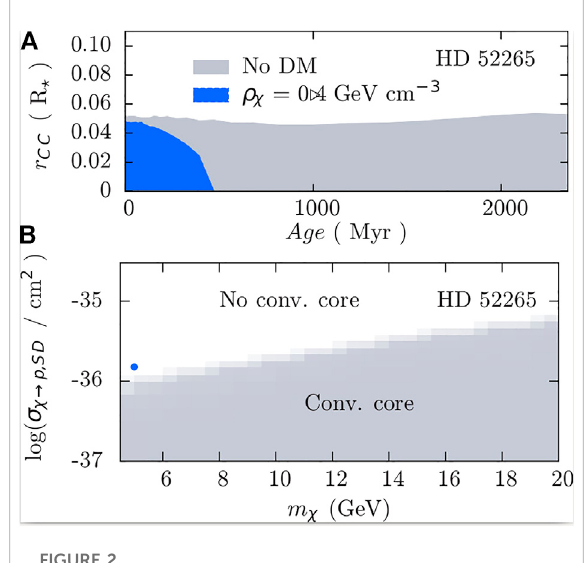
FIGURE 2 Upper (A) : convective core radius (r cc ) vs. star age, computed for two evolution models of the star HD 52265 (1.18 M ⊙ ), one of them without dark matter (grey); the other considering the presence of asymmetric dark matter (ADM) with mass m χ = 5 GeV , cross-section 1.5 × 10 – 36 cm 2 , and a density ρ x = 0.4 GeV cm − 3 (blue). Notice that the convective core rapidly disappears at thebeginningofthemainsequence.Lower (B) :HD52265models, at its estimated age, considering the action of ADM particles. The vertical axis is the logarithm of the spin-dependent baryon-dark matter cross section (log ( σ χ → p )), the horizontal axis is the dark matter particle mass (m χ ). Only some values are compatible with the existence of a convective core (notice the transition between the white and the gray shaded area, de fi ning the separation between the regions where the convective core is excluded or not). The blue point corresponds to the ADM model with the conditions of the upper panel. Taken by Casanellas and Lopes